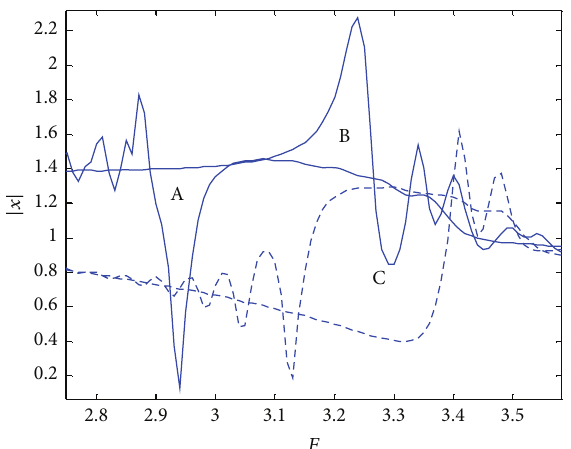
Figure 13: Local amplification of bistable